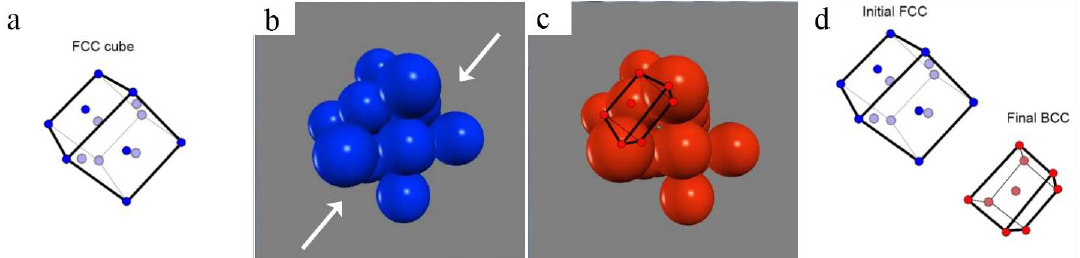
Figure 20. Bain distortion with hard-spheres. ( a ) Initial fcc lattice; ( b ) same crystal with hard spheres. The direction of the contraction axis along a <100> direction is marked by the white arrows. ( c ) Final distorted crystal, which is half a bcc crystal cut on a (110) plane; ( d ) Initial fcc crystal and final bcc crystal after Bain distortion. Movie at http://lmtm.epfl.ch/research.